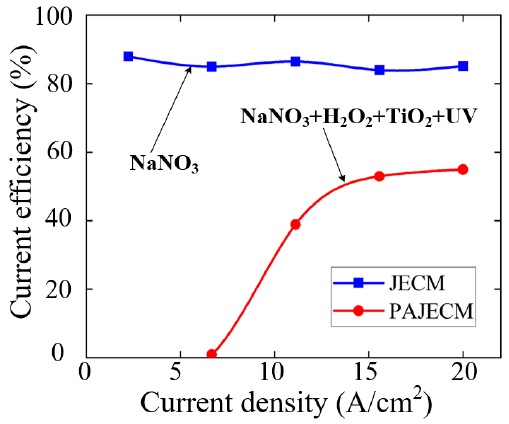
Figure 10. Comparison of current efficiency curves .